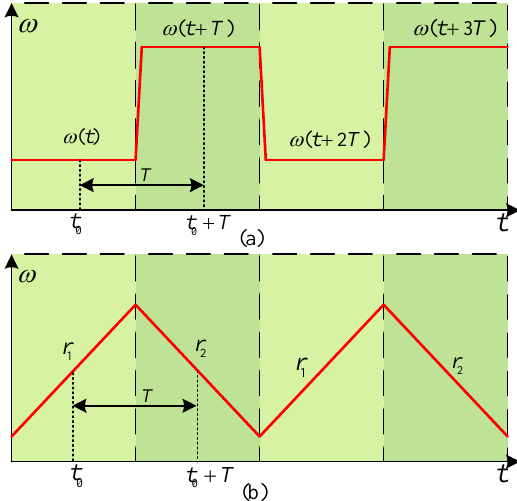
Figure 5. Principle diagram of parameter estimation: ( a ) Estimating B ; ( b ) estimating J .